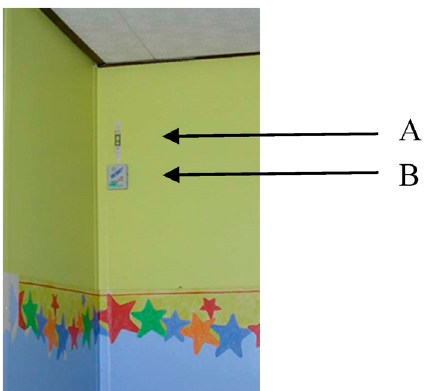
Figure 1. Typical sensor locations on the inside of the external wall in an index child’s bedroom ( A : fungal detector, B : temperature and relative humidity